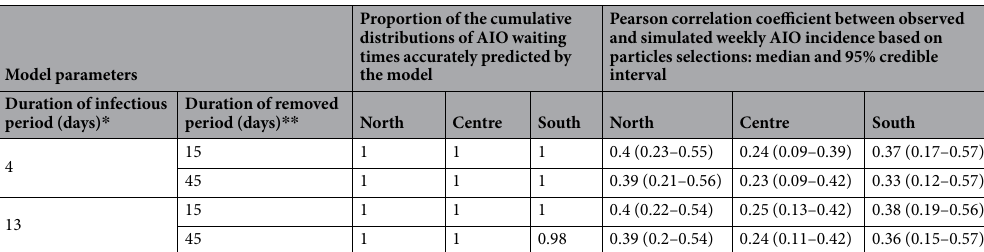
Model parameters